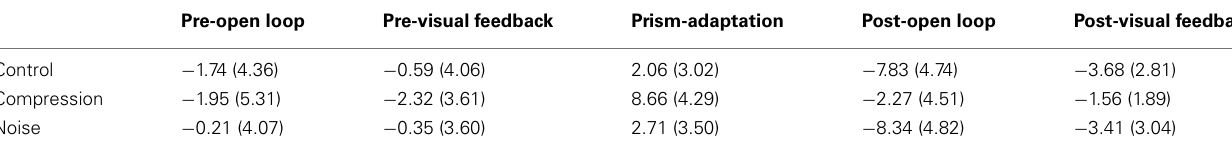
Table 2 | Mean (with SD) directional pointing error in degrees for the first four trials in each phase in the Control, Compression, and Noise conditions.